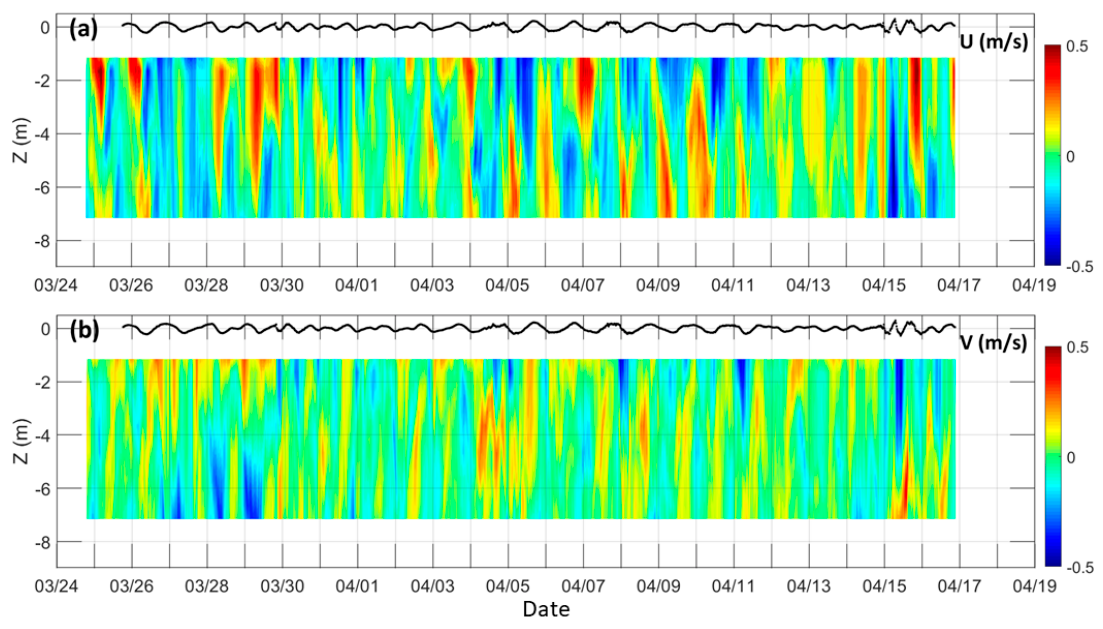
Figure 8. Time series of Acoustic Doppler Current Profiler (ADCP) currents from mooring LM5. ( a ) U component (flow toward the east positive); ( b ) V component (flow toward the north positive). Black lines at the top of each panel indicate water height.